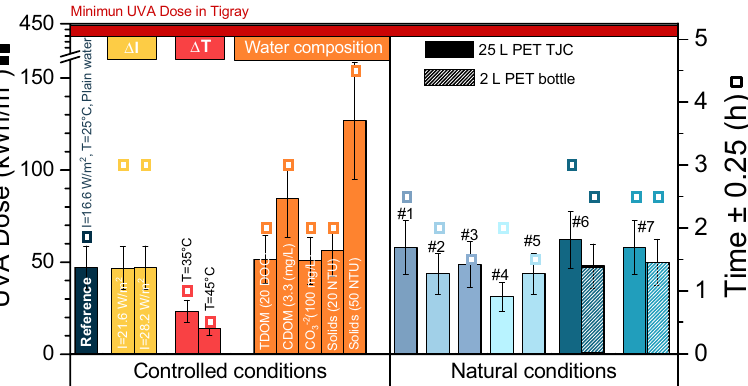
Controlled conditions Natural Figure 3. UVA dose (bars) and time (squares) to achieve 3-LRV in SODIS containers under controlled conditions (yellow: UVA irradiance (I), red: temperature (T), orange: water composition) and different natural conditions: well water and #1: I = 23.2 W/m 2 , T = 23–27 °C; #2: I = 21.9 W/m 2 , T = 26–32 °C; #3: I = 39.1 W/m 2 , T = 29–33 °C; #4: I = 15.7 W/m 2 , T = 40–41 °C; #5: I = 29.2 W/m 2 , T = 40–42 °C; #6: I = 20.7 W/m 2 , T = 23–26 °C; and #7: I = 23.2 W/m 2 , T = 17–31